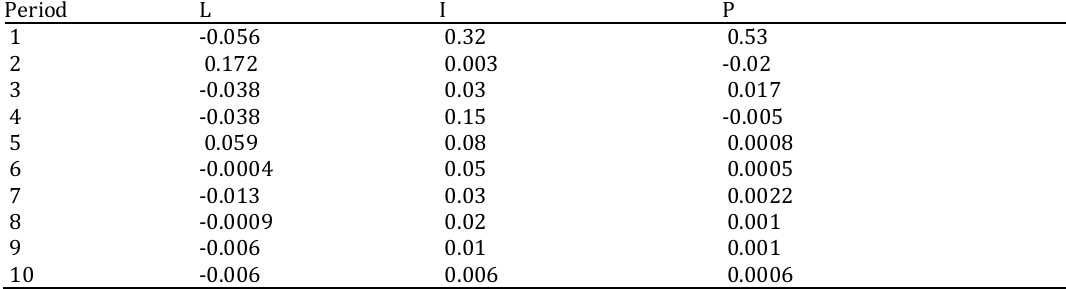
Table 6: Response to the change in gross written premium income to a shock in variables Period